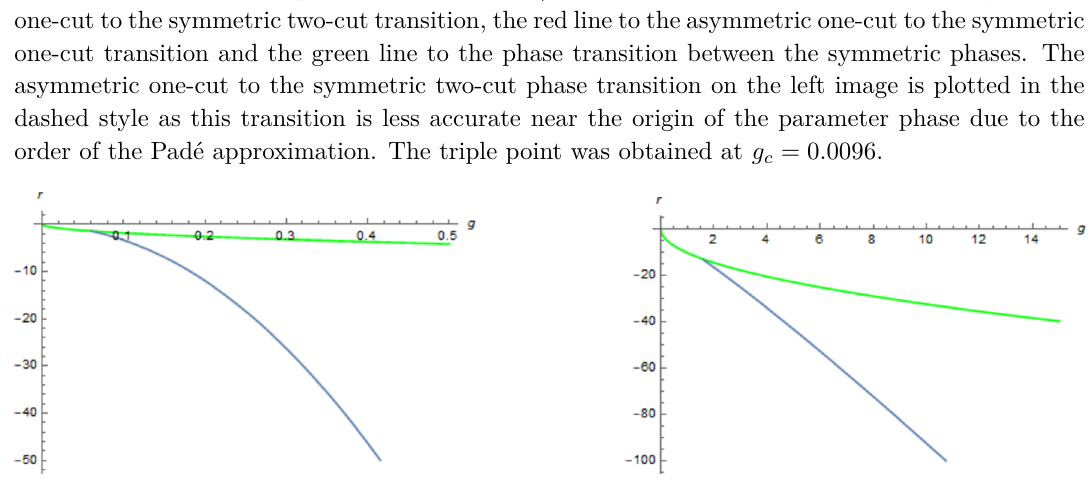
Figure 8 . The phase diagrams for the value α 0 = 1 / 8 (left) and α 0 = 1 (right). The blue line corresponds to the asymmetric one-cut to the symmetric two-cut transition and the green line to the transition between the symmetric phases. The triple points were determined at g c = 0 . 054 and g c = 1 . 43